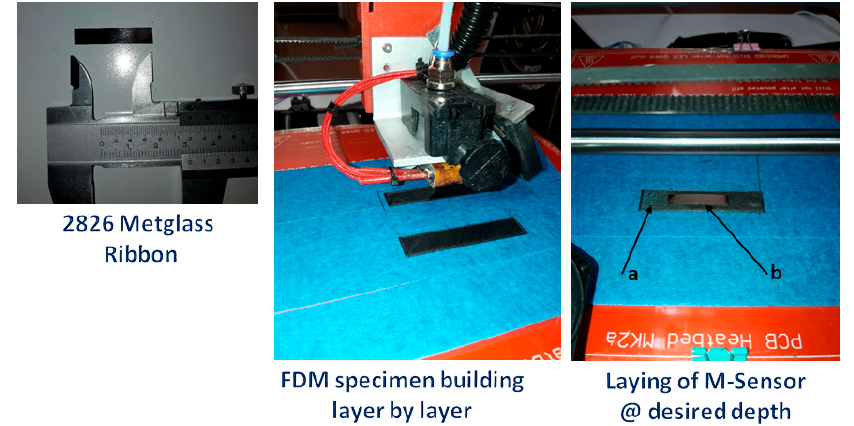
Figure 1. Smart slab preparation showing the strip of magnetoelastic 2826 Metglas ® ribbon material and two views of the carbon fiber PET-G layers ( a ) during the process of ribbon ( b ) integration.